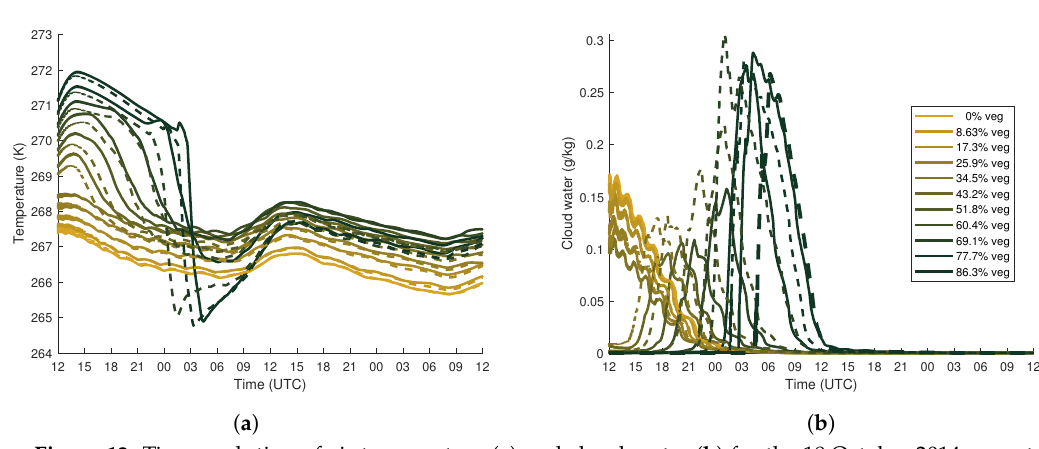
Figure 12. Time evolution of air temperature ( a ) and cloud water ( b ) for the 18 October 2014 case at 117 m for each vegetation percentage. Solid lines denote the experiments using the multilayer SBL scheme and the dashed lines denote the experiments using the single layer scheme.